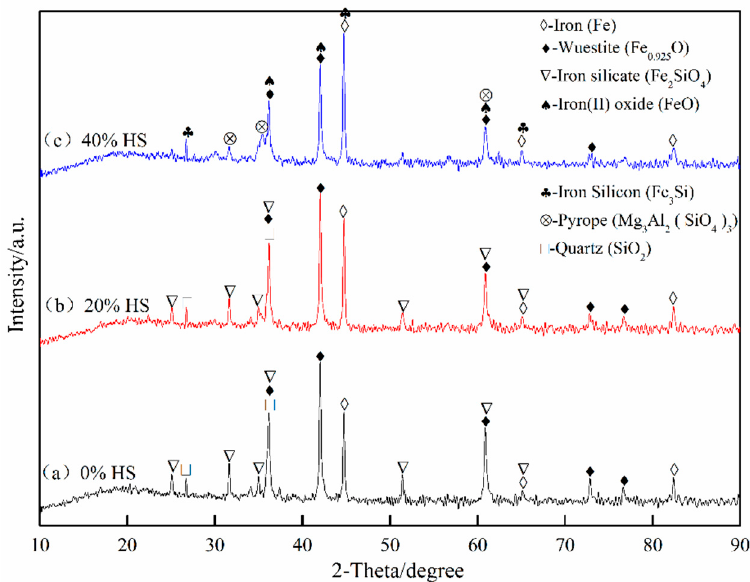
Figure 11. XRD pattern of oxidized pellets after reduction swelling with different the dosage of sea sand ore.